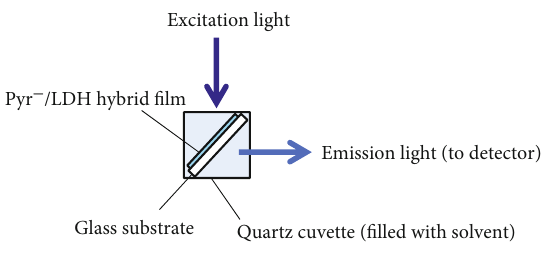
Figure 2: Top view of setup for emission measurement of the fi lm (top view).